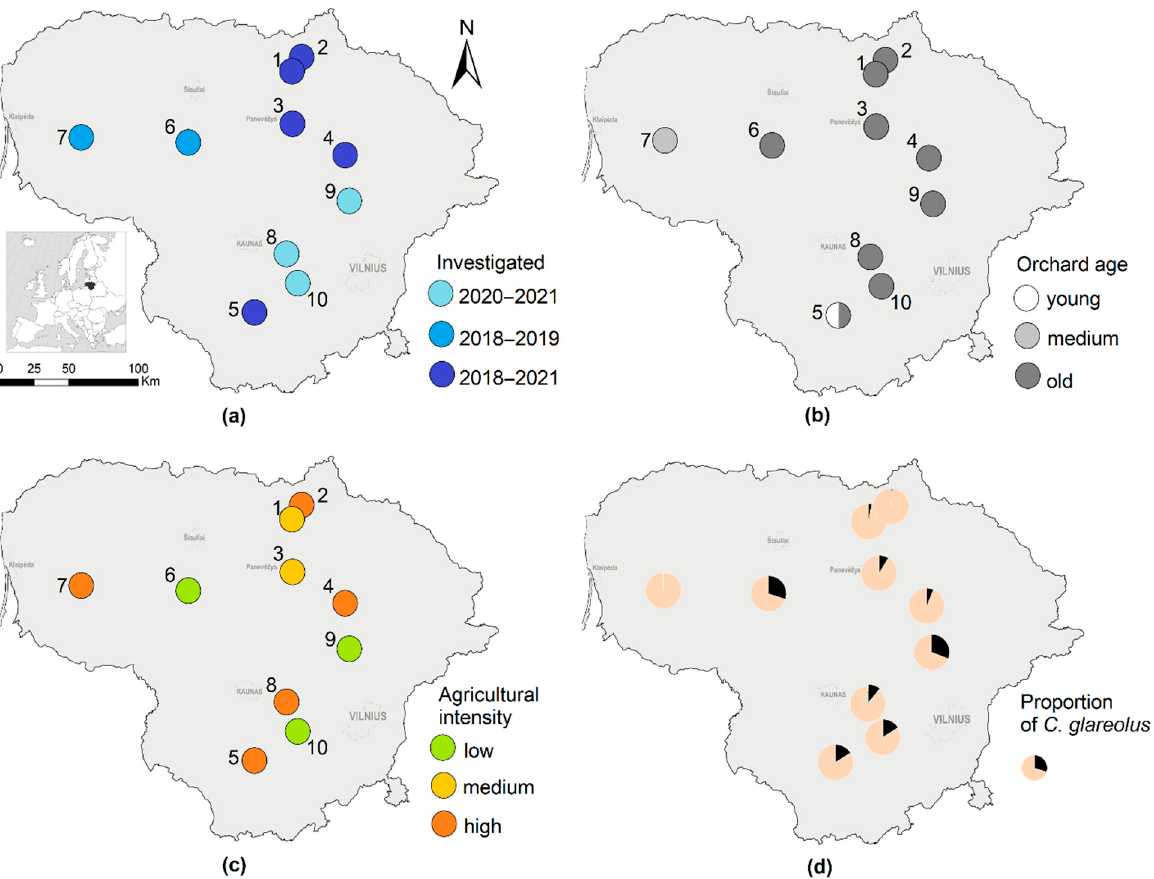
Figure 1. Investigated apple orchards in Lithuania, 2018–2021: ( a )—position of study sites with length of the study indicated; ( b )—age of orchard; ( c )—intensity of agricultural measures; ( d )—proportion of C. glareolus in all trapped small mammals.